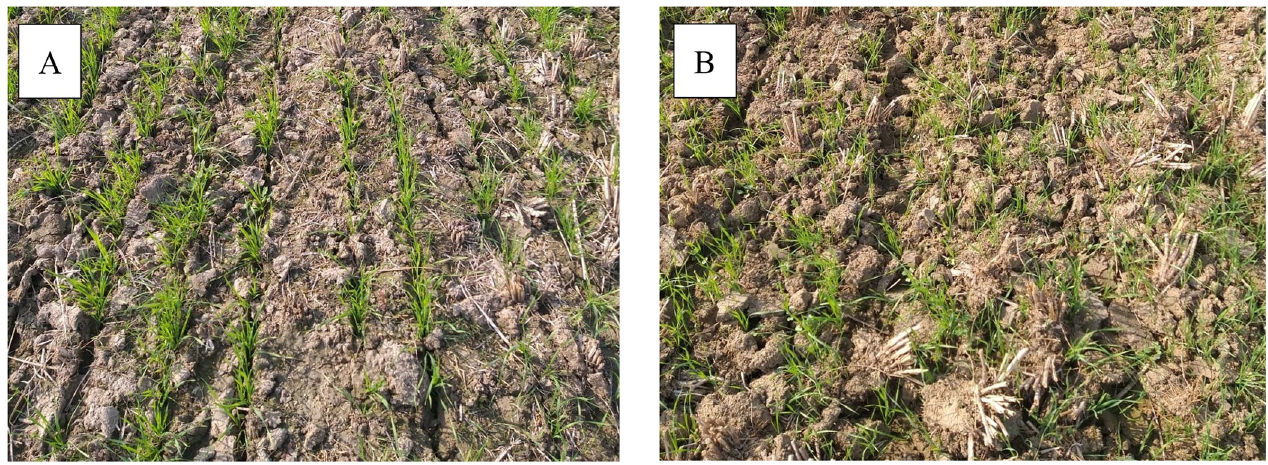
Fig 2. Photos of example zero tillage (A) and conventional tillage (B) fields.